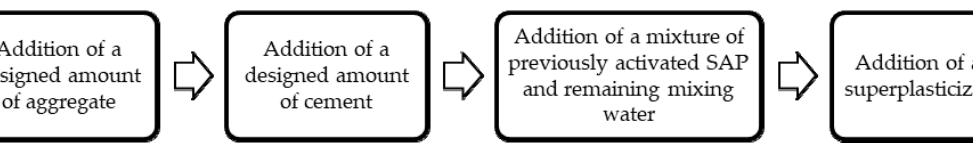
Figure 2. Method R: The order in which components were added to the concrete mix when using the methodology of adding non-activated superabsorbent polymers (SAP). Materials 2018 , 11 , x FOR PEER REVIEW